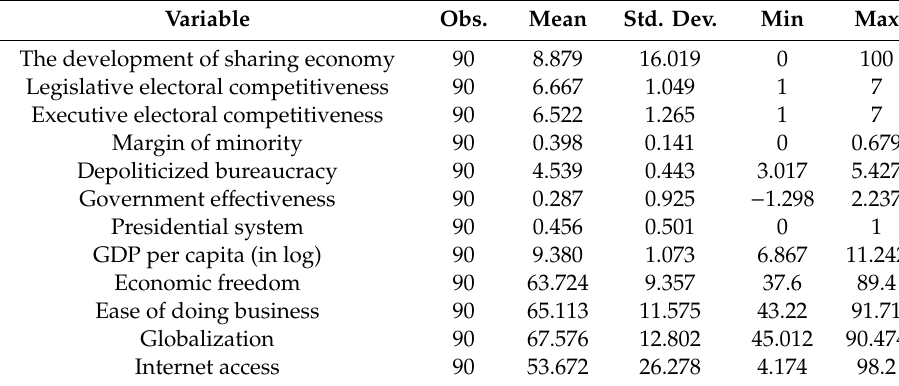
Table 1. Summary